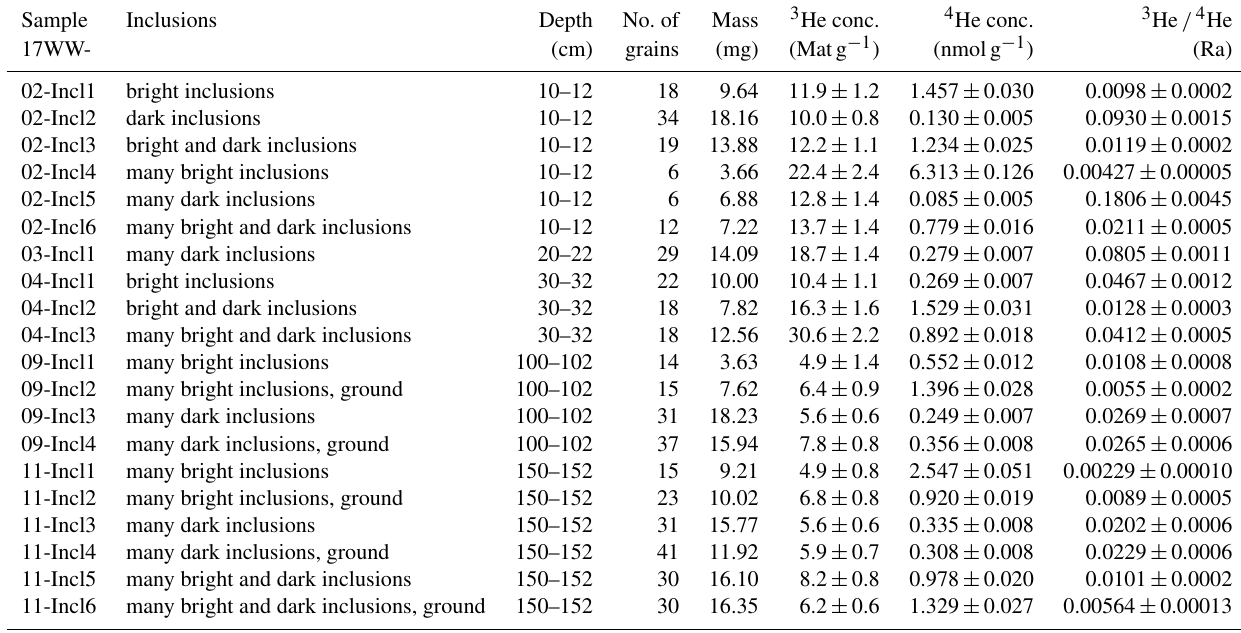
Table 3. 3 He and 4 He concentrations of magnetite aliquots with inclusions, as confirmed by microCT.